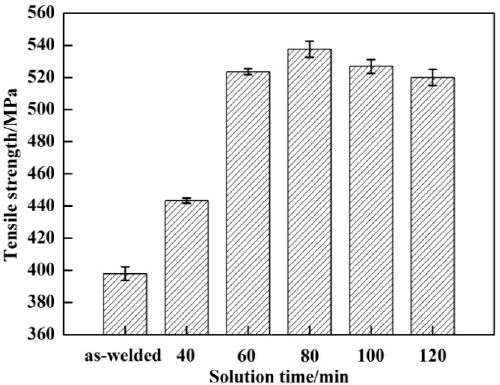
Figure 10. Tensile strengths of welded joints between as-welded and PWHT with solution at 490 °C for different time followed by aging at 120 °C for 24 h.